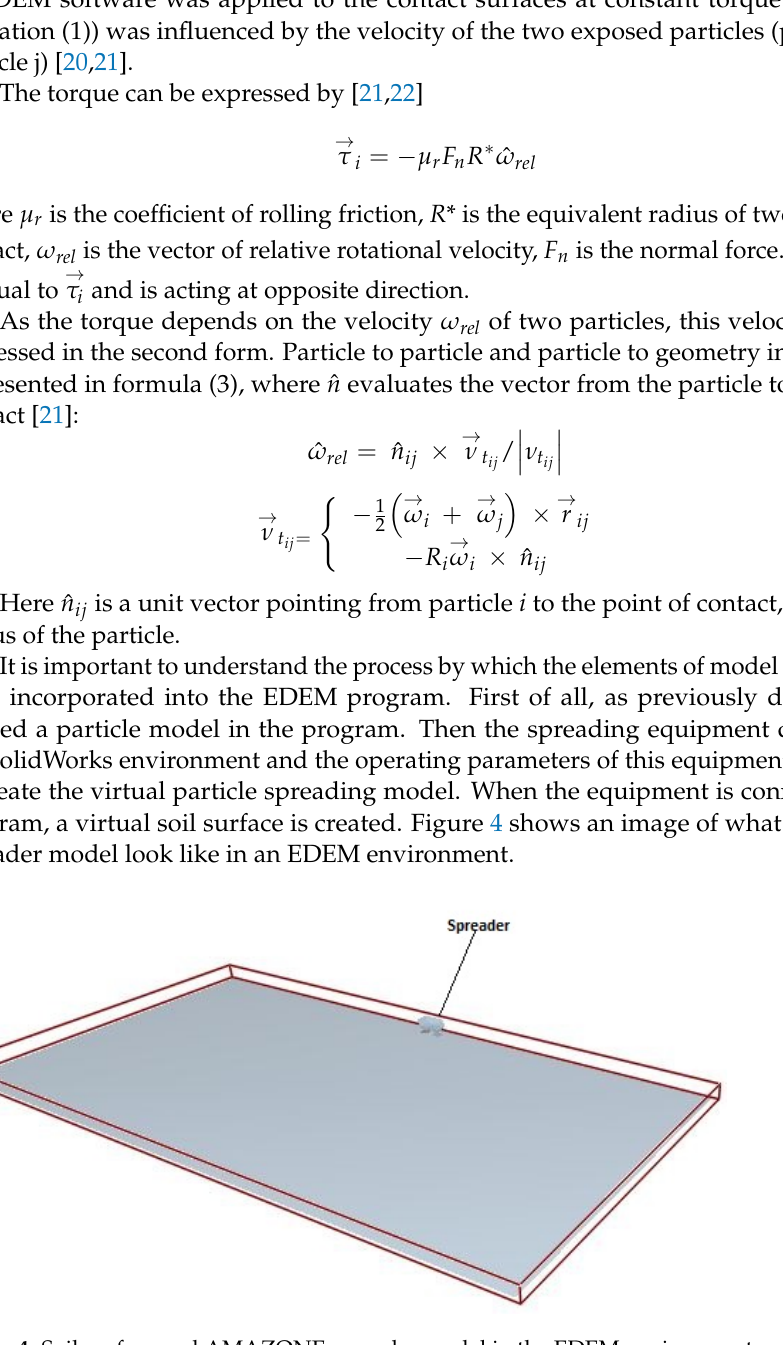
Figure 4. Soil surface and AMAZONE spreader model in the EDEM environment.